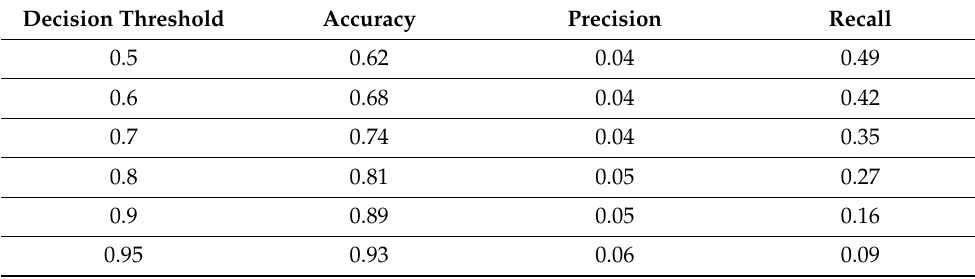
Table 3. Accuracy, precision, and recall of DCNN predictions for the extended validation dataset.